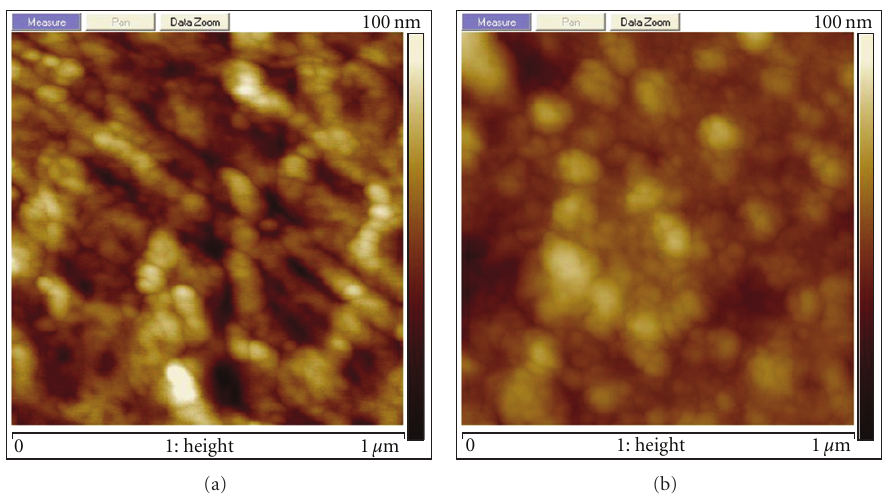
Figure 12: AFM topographic image for C5FNDHIS (a) and P5FNDIHS (b)